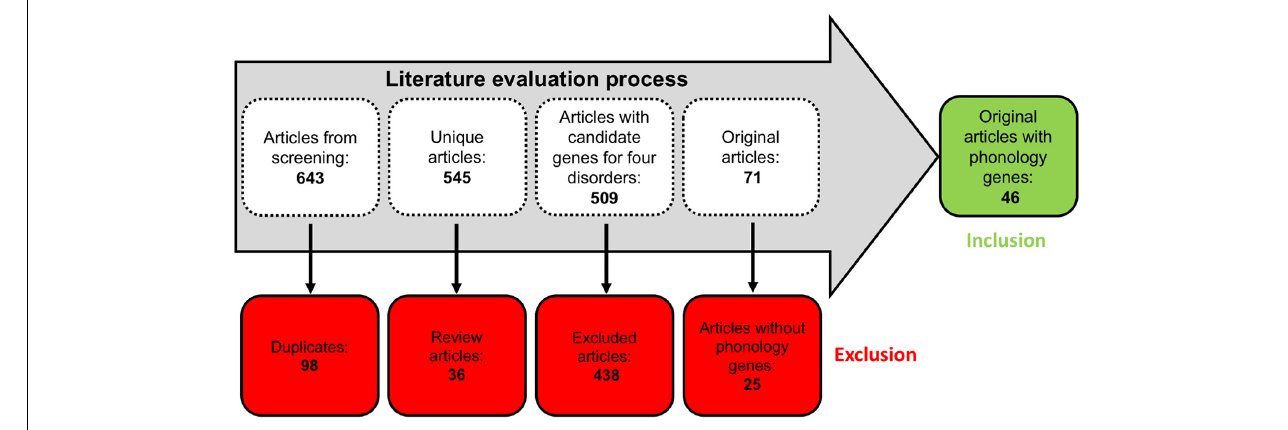
FIGURE 2 | Workflow of the literature evaluation process.